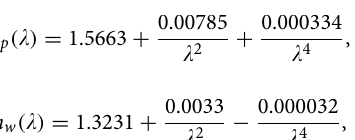
where is expressed in microns. The calculated values were then compared with experimental results reported by He et al . 32 . After confirming the accuracy of the calculations, the same method was applied to 0.41-µm and 0.42-µm particles in 90% glycerol/water at (cid:31) = 520 nm only. Image analysis. Images of rapid antigen test strips for COVID-19 were acquired with a laser multifunction printer (HP Color LaserJet Pro MFP M479) and color intensities in the green channel were analyzed with the ImageJ software (National Institutes of Health). Data availability All the data are available on request from the corresponding author